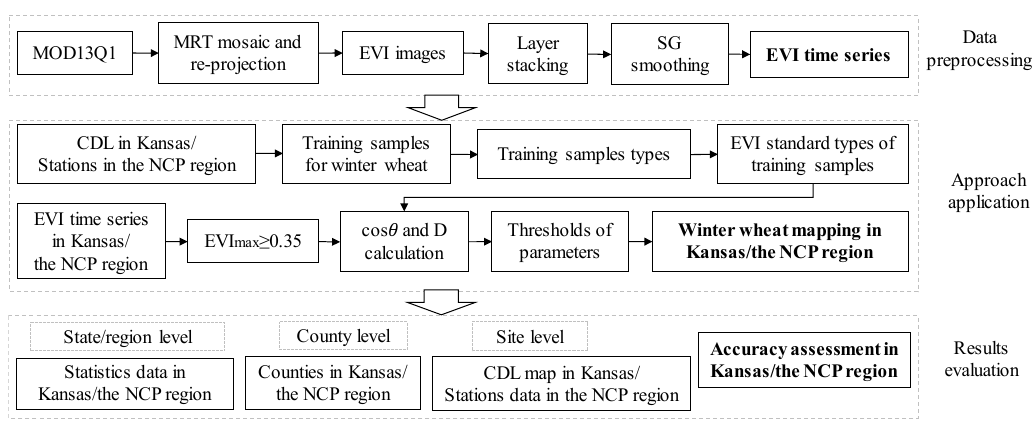
1 Green color represents sowing, light green represents the development of winter wheat, gray represents over-winter, and orange represents harvesting. E, M, and L represent the early 10 days, the middle 10 days, and the last 10 days of a month, respectively. 3.2. Data Preprocessing The MODIS Reprojection Tool (MRT) (http://edcdaac.usgs.gov/datatools.asp) was used to generate EVI mosaics spanning three MODIS scenes (h09v05, h10v04, h10v05) for Kansas and five